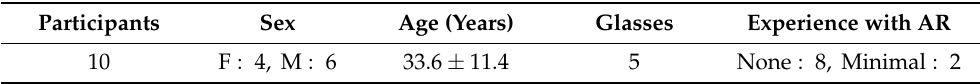
Table 1. Participant details in the point-and-trace user-study.